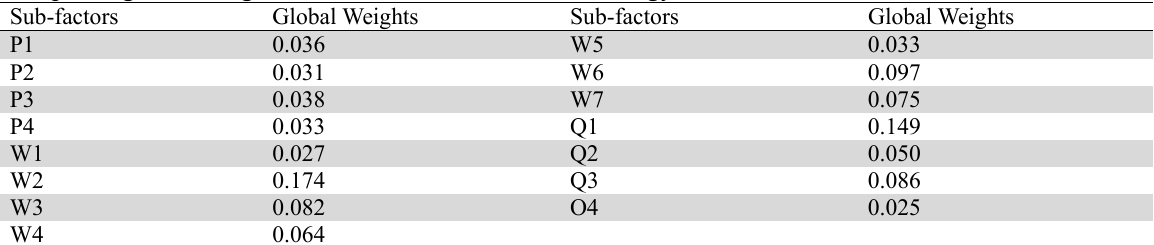
Computed global weights for sub-factors for mixed strategy Sub-factors Global Weights Sub-factors Global Weights P1 0.036